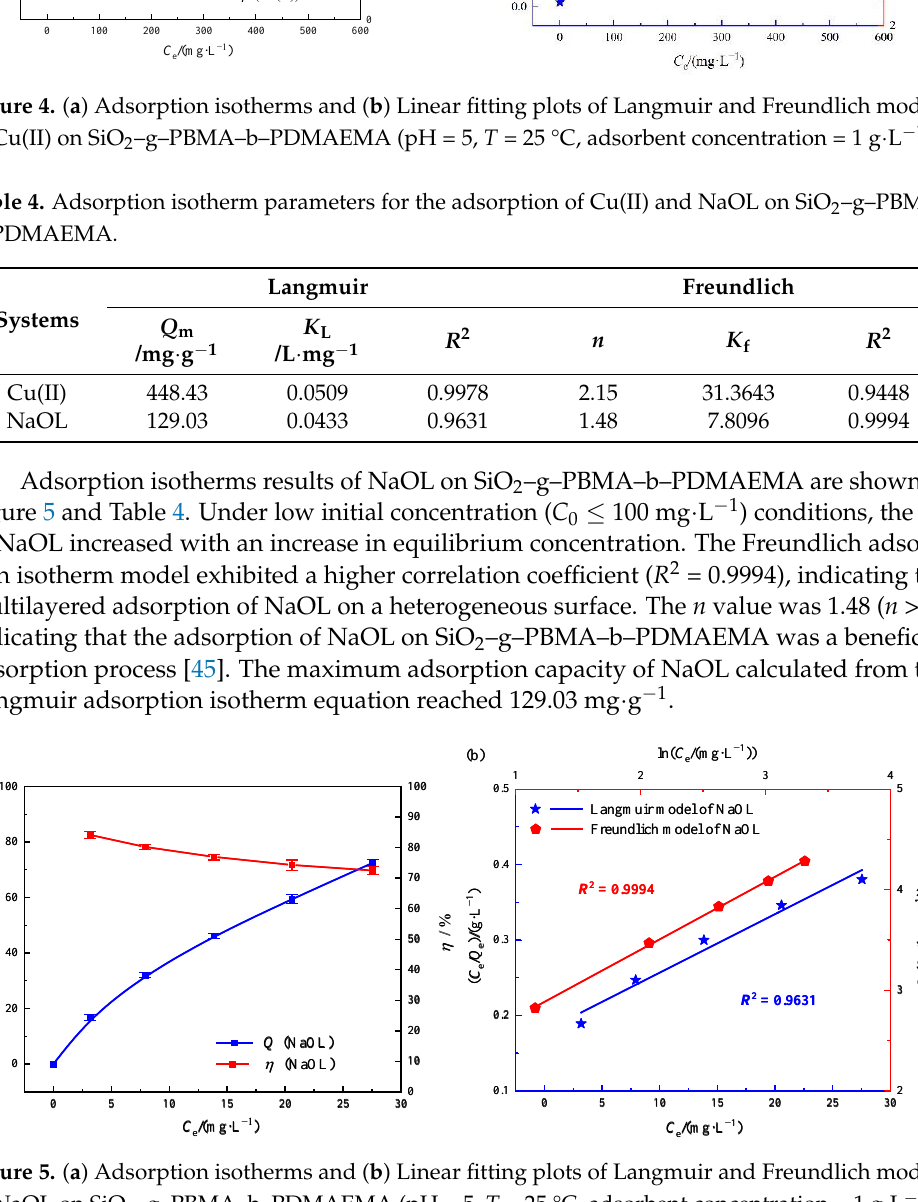
Figure 5. ( a ) Adsorption isotherms and ( b ) Linear fitting plots of Langmuir and Freundlich models of NaOL on SiO 2 –g–PBMA–b–PDMAEMA (pH = 5, T = 25 ℃ , adsorbent concentration = 1 g·L −1